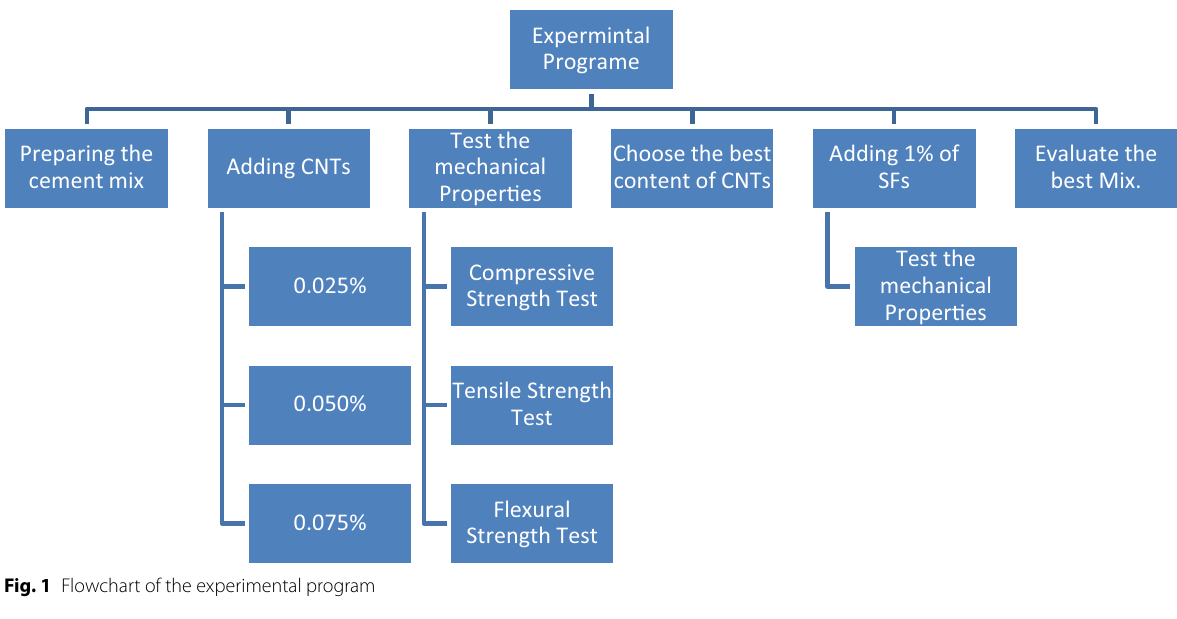
Fig. 1 Flowchart of the experimental program